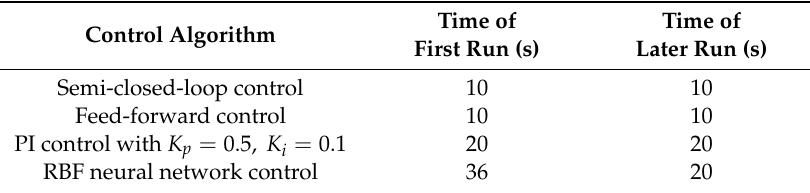
Table 4. Tracking time of di ff erent control